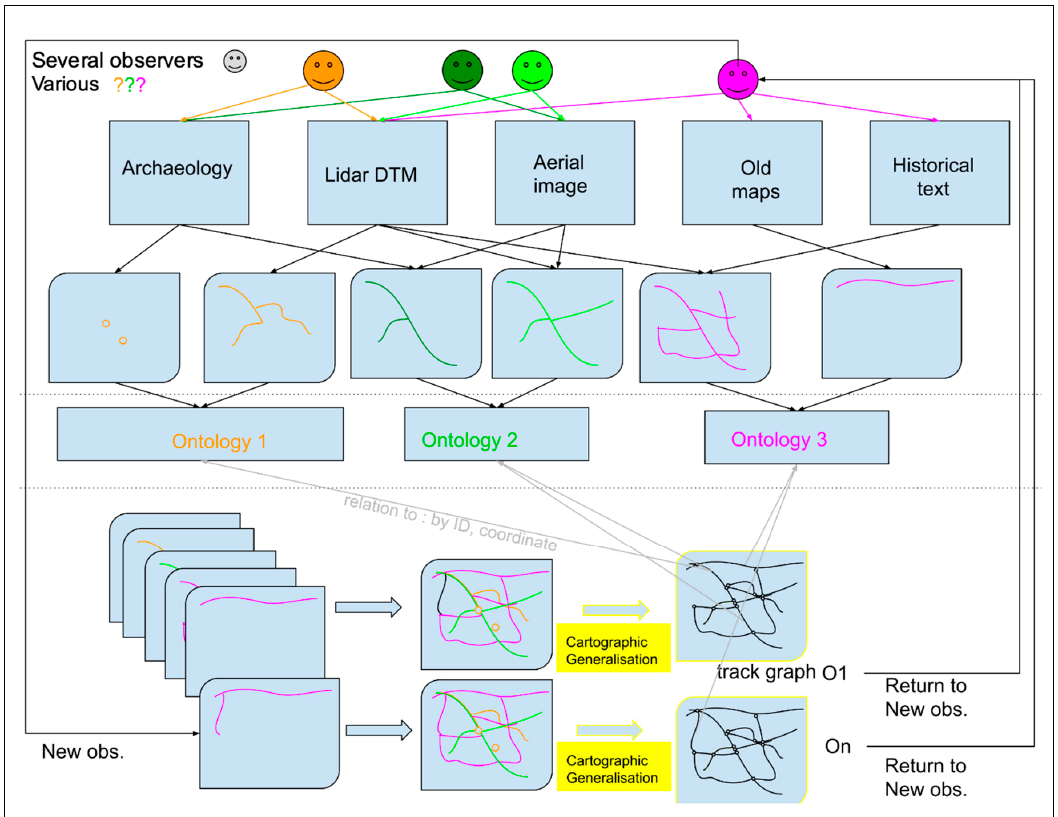
Figure 11. The track graph creation process.